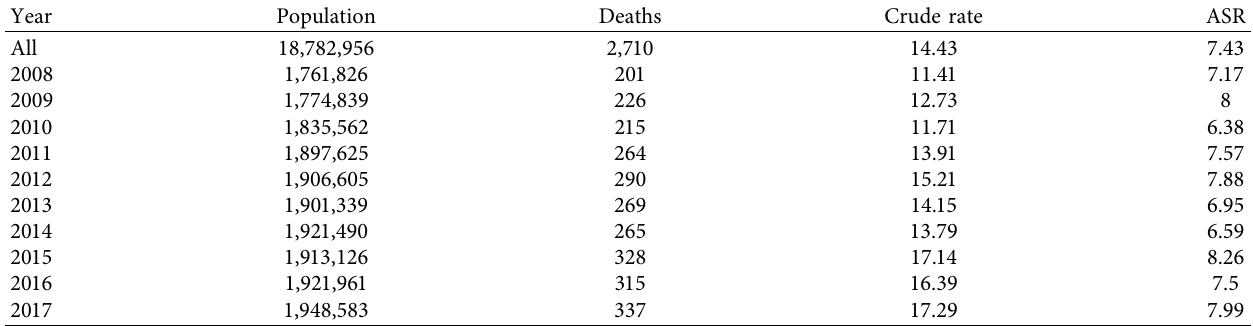
Table 5: Mortality of female breast cancer in urban Shenyang in 2008–2017.